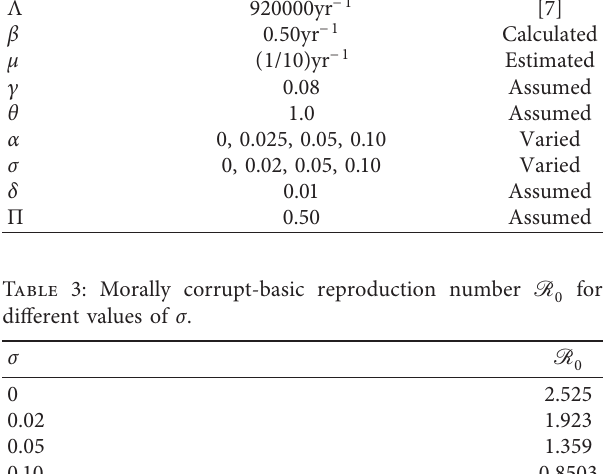
Table 4: Morally corrupt-basic reproduction number R